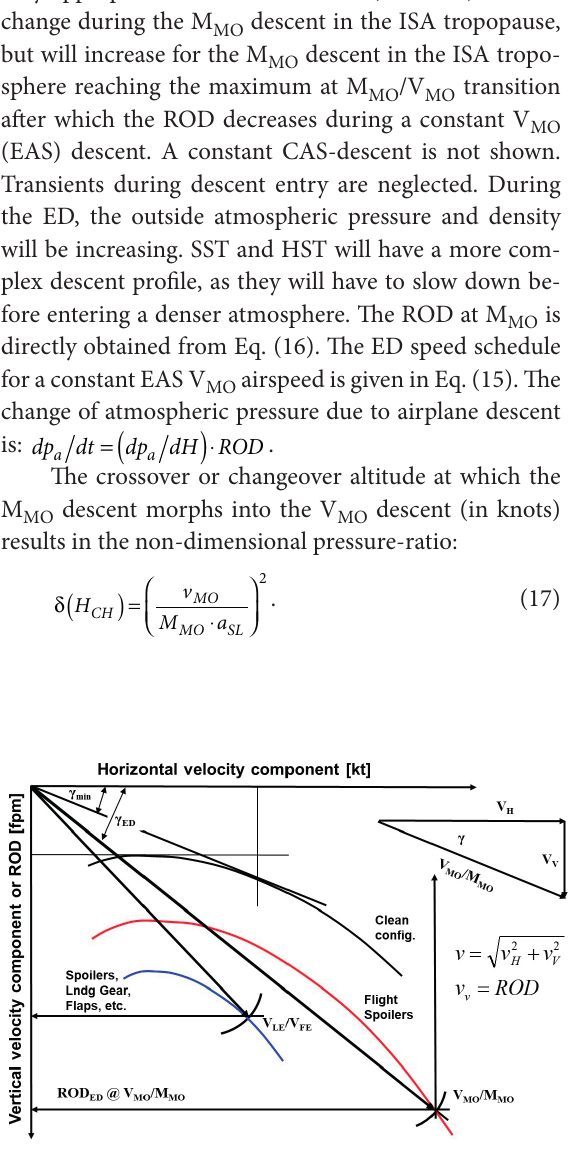
Fig. 4. M MO /V MO ISA ED speed schedule. Not to